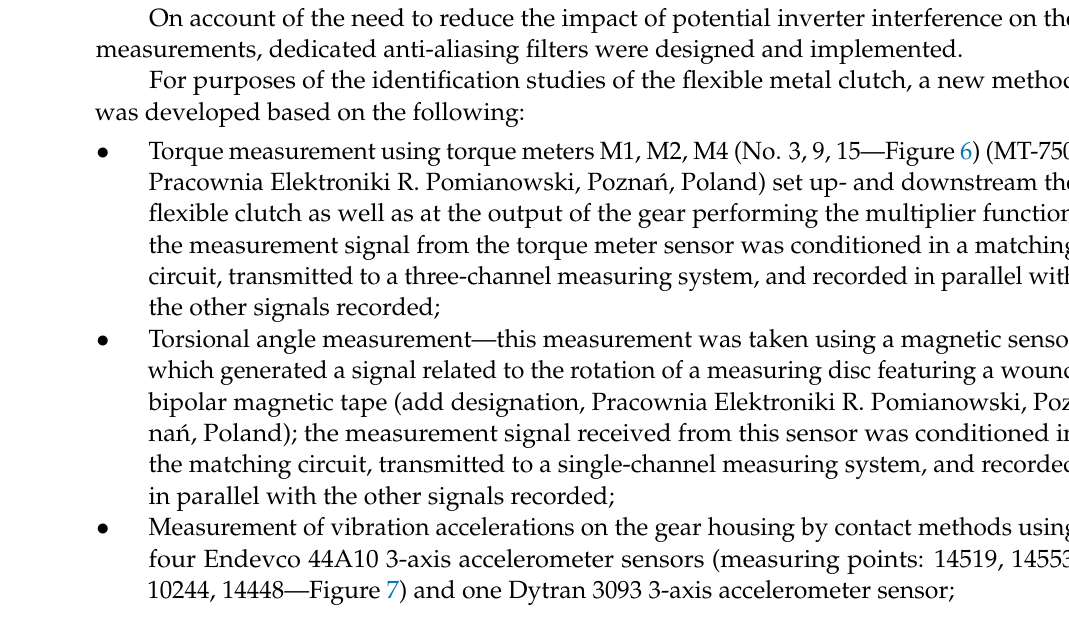
Table 1. Summary of test variants .